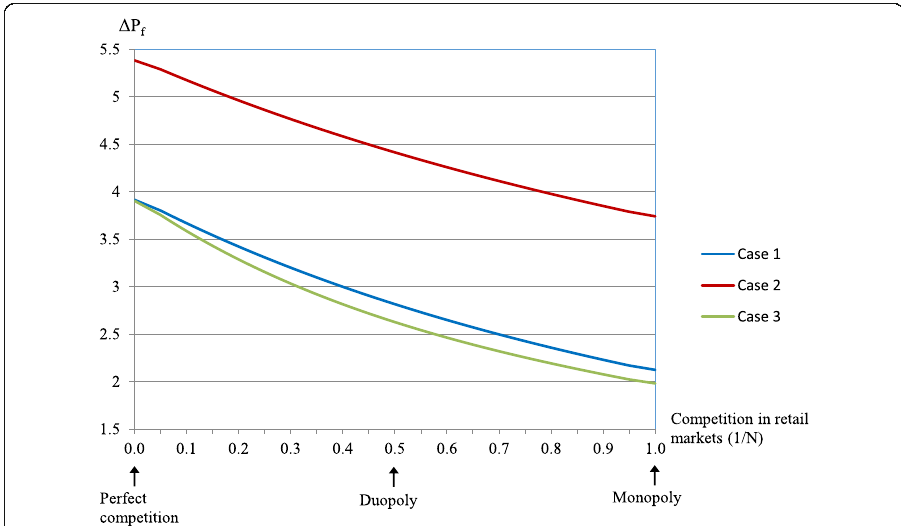
Fig. 1 Farm price increase ( Δ P f ) due to the weakened buyer power in agricultural procurement under various levels of seller power in retail markets. Note: Δ P f is the increase in farm price when processors ’ buyer power is weakened from M =2 to M =3. The increase ( Δ P f ) is smaller when retailers have stronger seller power in retail markets. Case 1 is when there is a competitive wholesale market. Case 2 is when there is an oligopoly wholesale market. Case 3 is when there is an oligopsony wholesale market. Farm price increase in case 2 (red line) is larger than that in case 1 (blue line). The relative magnitudes between farm price increase in case 3 and those in cases 1 and 2 depend on various market factors so that all (in)equalities between them are